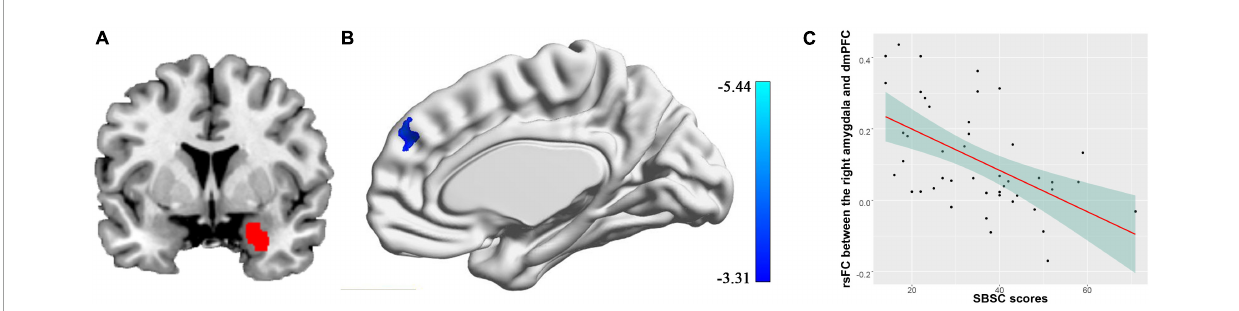
FIGURE2 Correlation between rsFC of the right amygdala with the dmPFC and stress responses in a sample consisting of 45 participants who completed the first survey. (A) The right amygdala; (B) the dmPFC whose rsFC with the right amygdala correlated with the stress behaviors during the COVID-19 outbreak; (C) a scatter plot showing the relationship between the rsFC and the stress responses.